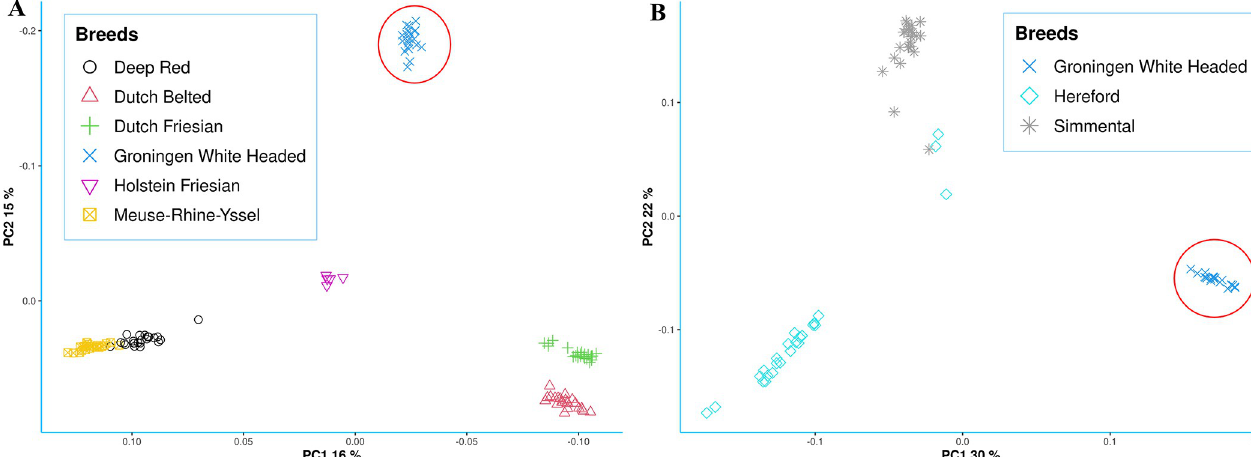
Fig 1. Principal component analysis (A) 120 samples from six breeds (Holstein Friesian, Dutch Friesian, Dutch Belted, Deep Red, Meuse-Rhine-Yssel and GWH); (B) The 70 animals from the three populations, GWH breed plus two white headed breeds (Hereford and Simmental) used for the GWAS in the second step. Individuals from the GWH breed (red circle) are distantly positioned from all other breeds in both plots. The % symbol indicates the percentage of the explained variance for the first and second components calculated from the eigenvalues.